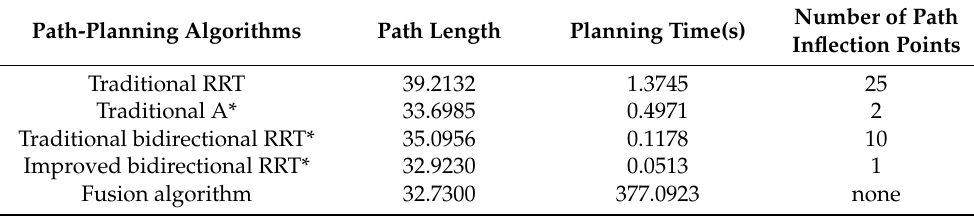
Table 2. Comparison of five algorithms.